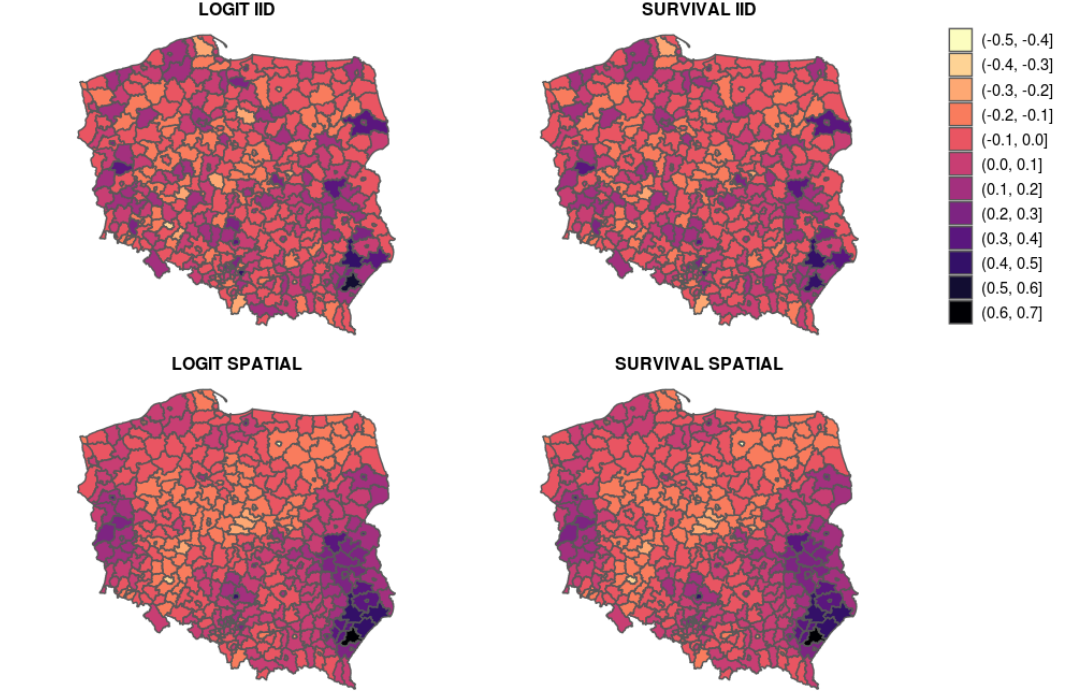
Figure 1. Posterior mean for the conditional i . i . d random variables in LOGIT IID and SURVIVAL IID models, and for spatially correlated random variables in LOGIT SPATIAL and SURVIVAL